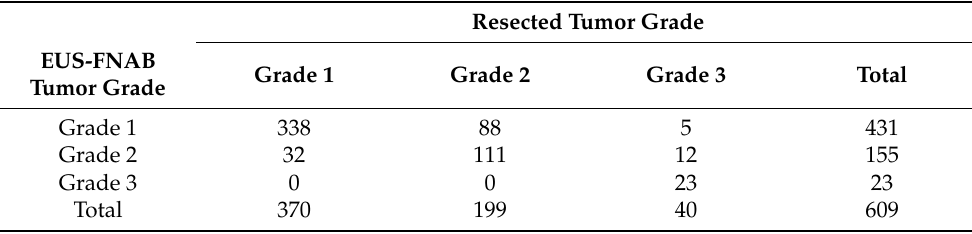
Table 3. Concordance of PNEN grading between EUS-FNAB specimens and surgical specimens